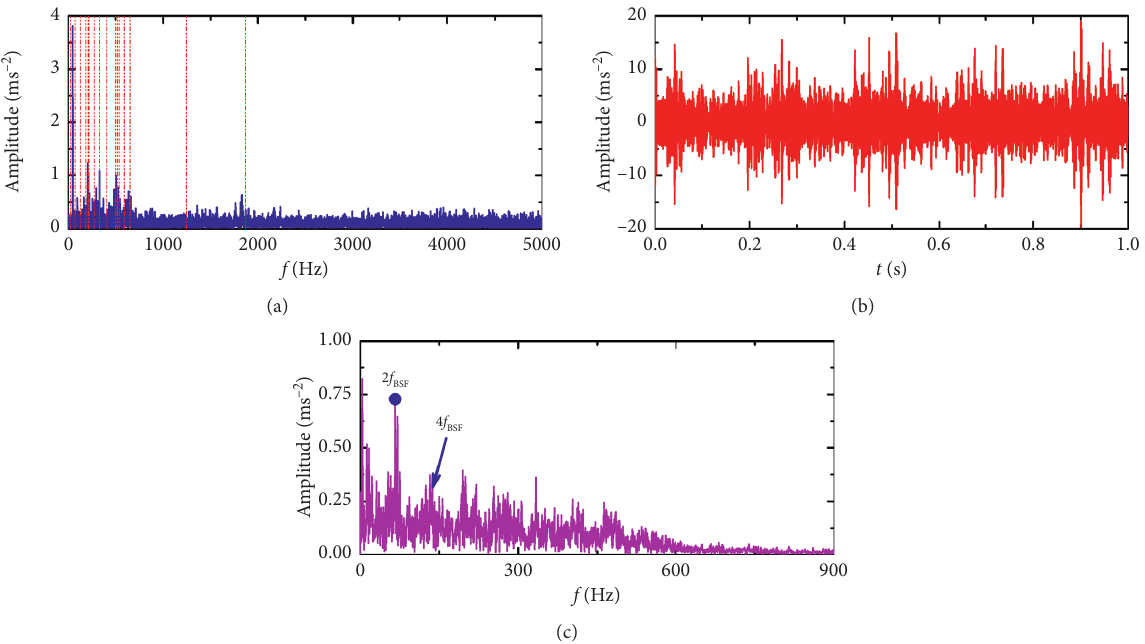
Figure 22: Results obtained by EWT: (a) detected boundaries of Fourier spectrum, (b) the 17th subband signal, and (c) Hilbert envelope spectrum of signal in